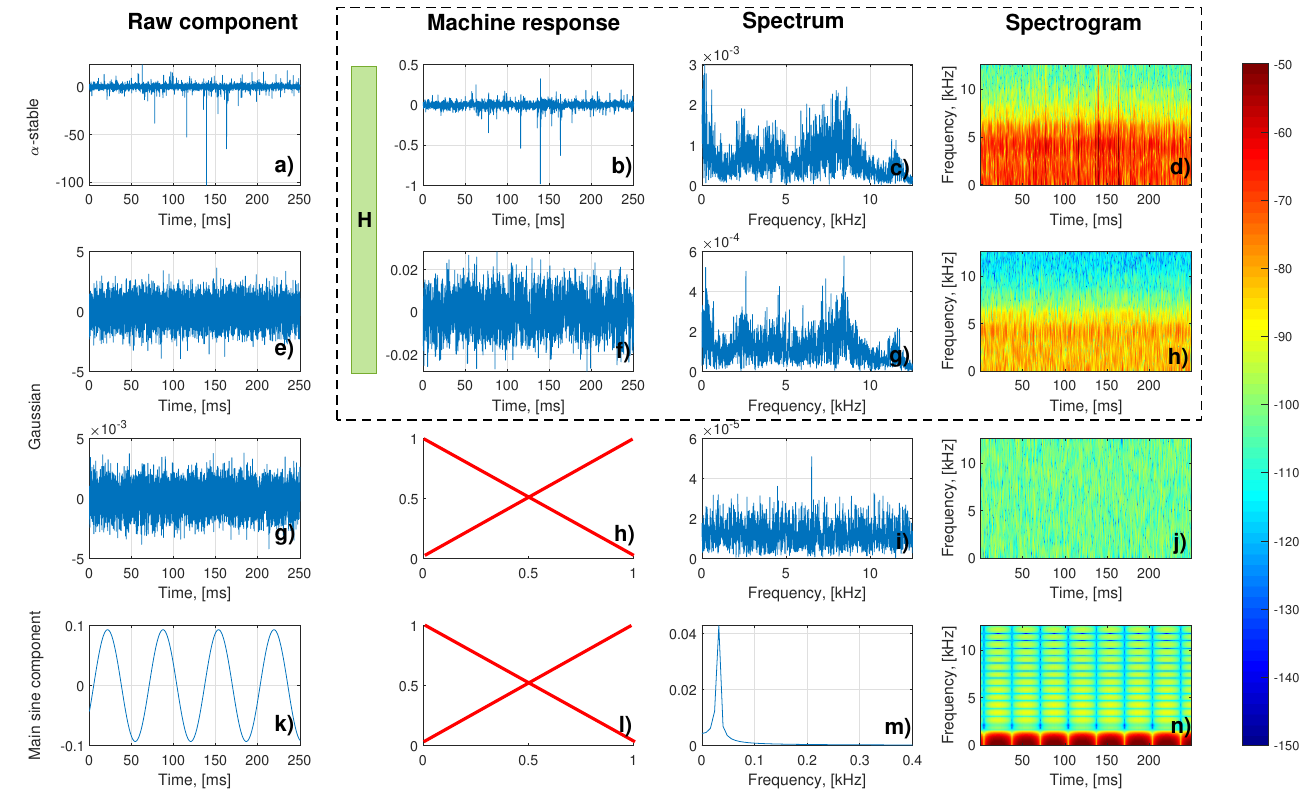
Figure 15. The components of the model mentioned in the scheme (Figure 7). Based on this figure one can see how important it is to use machine response as a part of the overall model. Firstly, Gaussian noise used as excitation for machine response (which simulates internal noises) resembles the background of the real signal very closely, which is the expected outcome (Figure 15e–h). It is especially visible comparing spectrograms of the simulated internal noises (Figure 15h) and the actual real signal (Figure 16 bottom-left panel). Similarly, process drawn from α -stable distribution (Figure 15a) used as excitation for machine response (which simulates ore-induced noises, see spectrogram at Figure 15d) takes a similar spectral shape, but is focused on describing the elementary excitations as time passes, which explains its irregular structure in the time domain. In Figure 16 on the left side, the time series and spectrogram for a one second of the real signal are presented, and on the right side—time series and spectrogram of the signal generated based on the presented model. The small differences between spectrograms can be observed. They are connected with shocks observed in the real data. In our